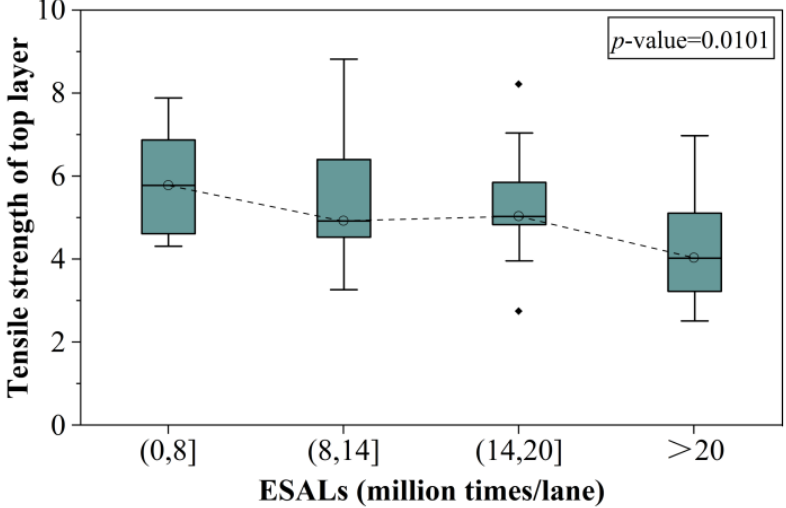
Figure 10. Relationship between tensile strength and ESALs for the top layer.